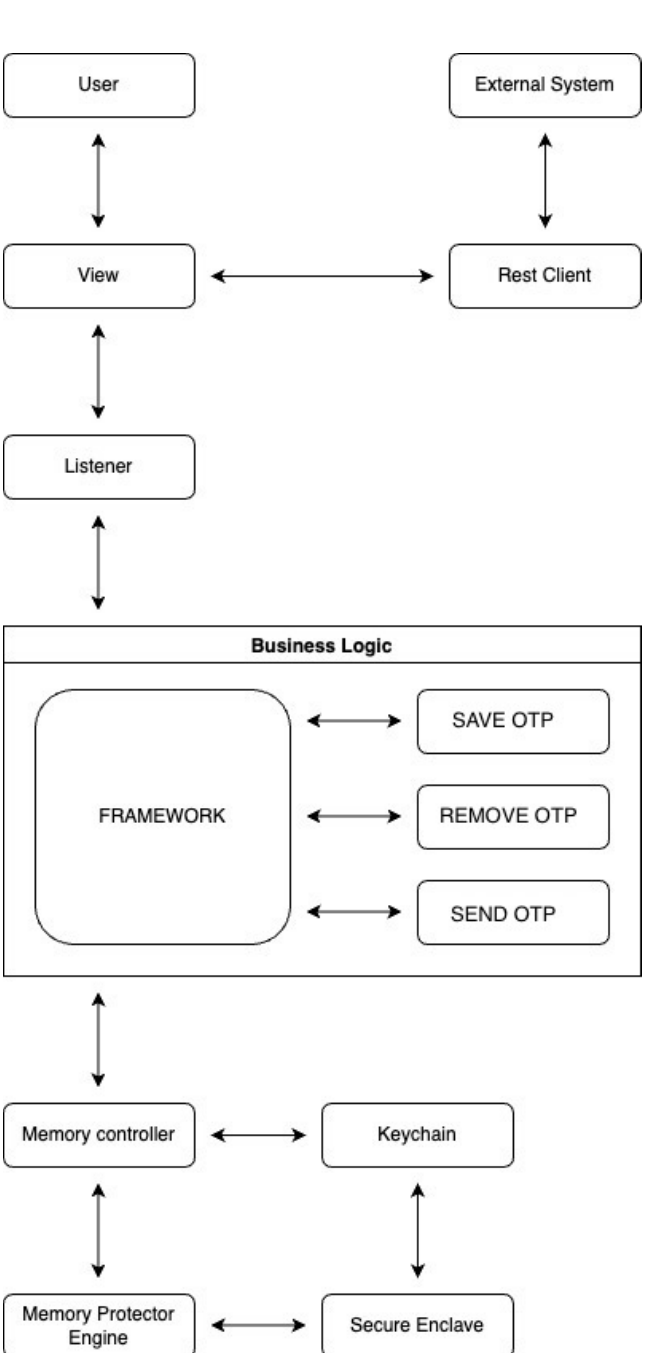
Figure 5. Logical structure of the application using a framework for isolated management of